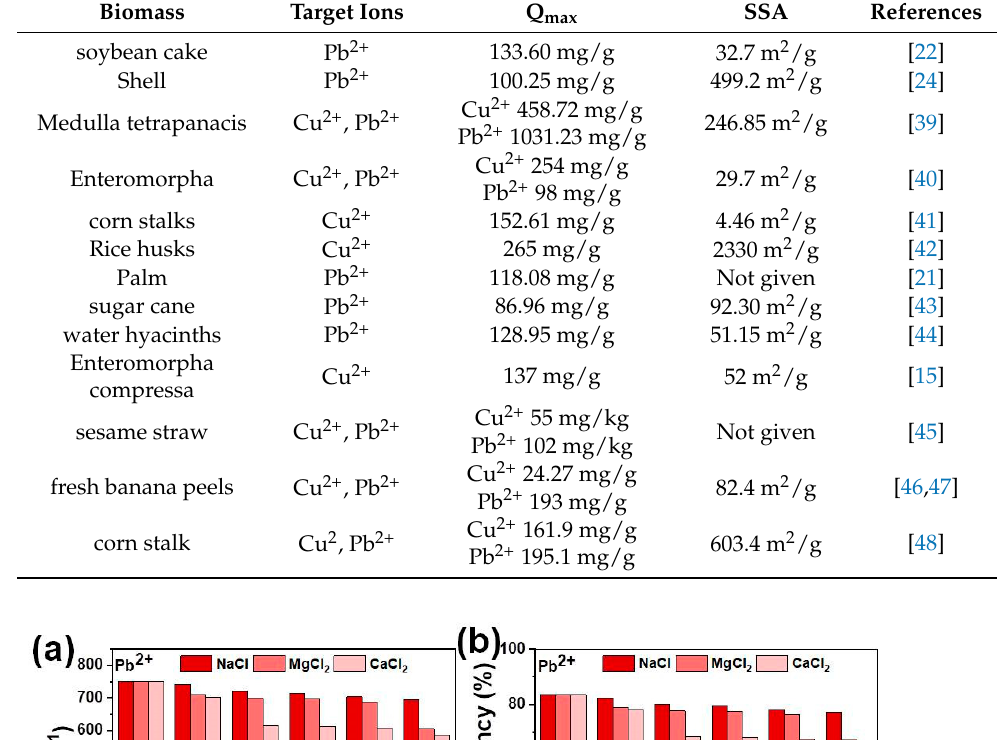
Table 6. The comparison on the adsorption performances.